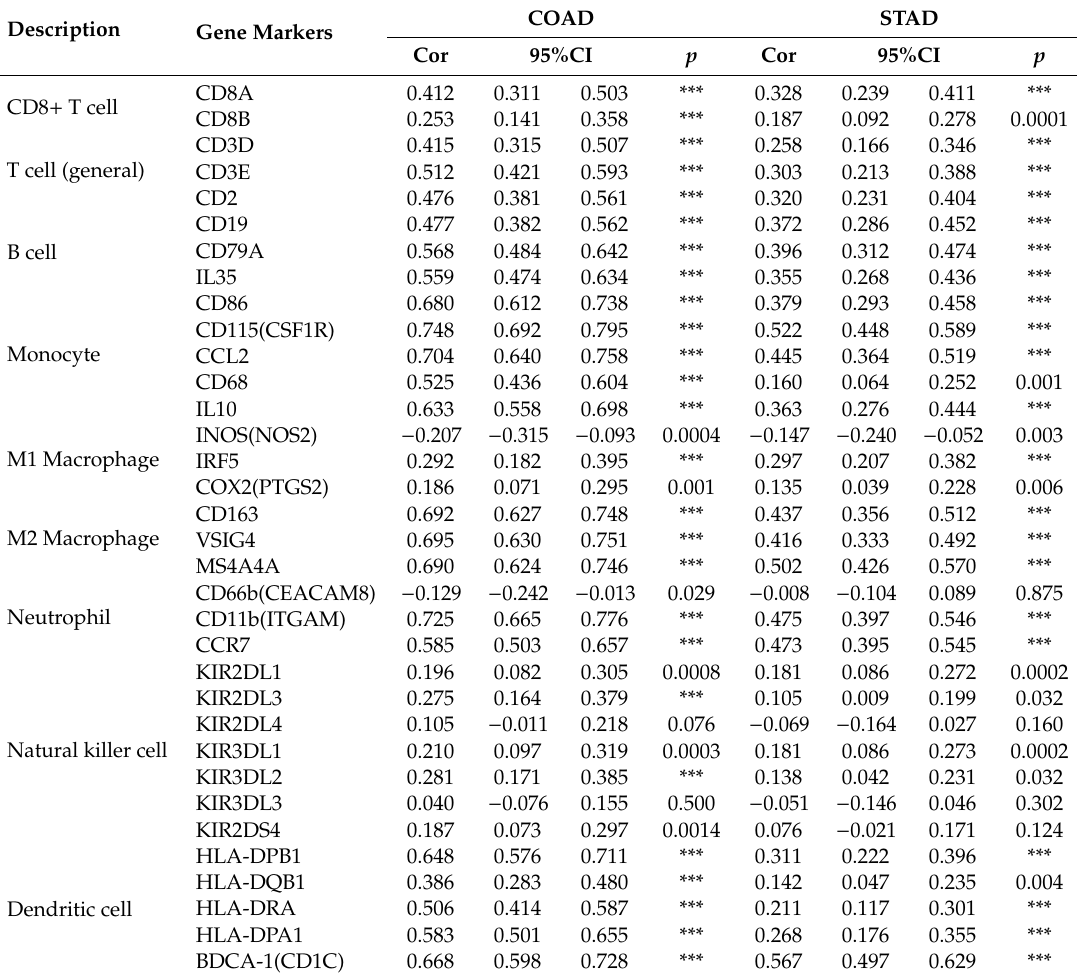
Table 1. Correlation analysis between DCLK1 and related genes and markers of immune